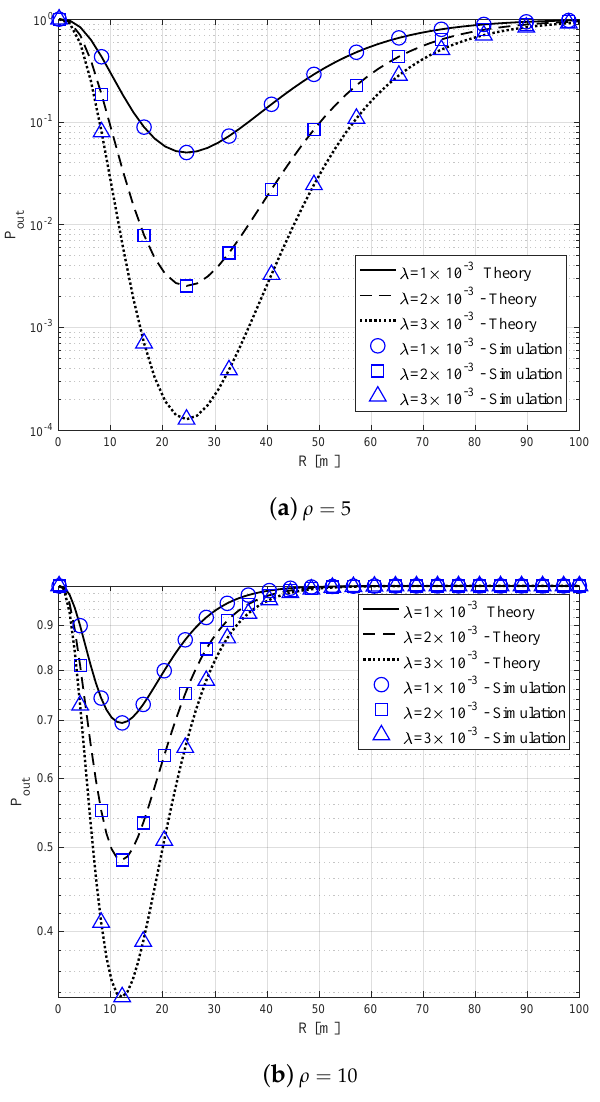
Figure 5. Outage probability versus radius R with β =